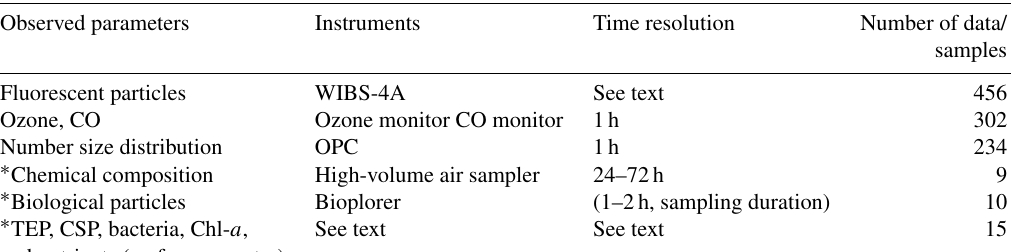
Table 1. Summary of observations during the cruise (*batch sampling/offline analysis).